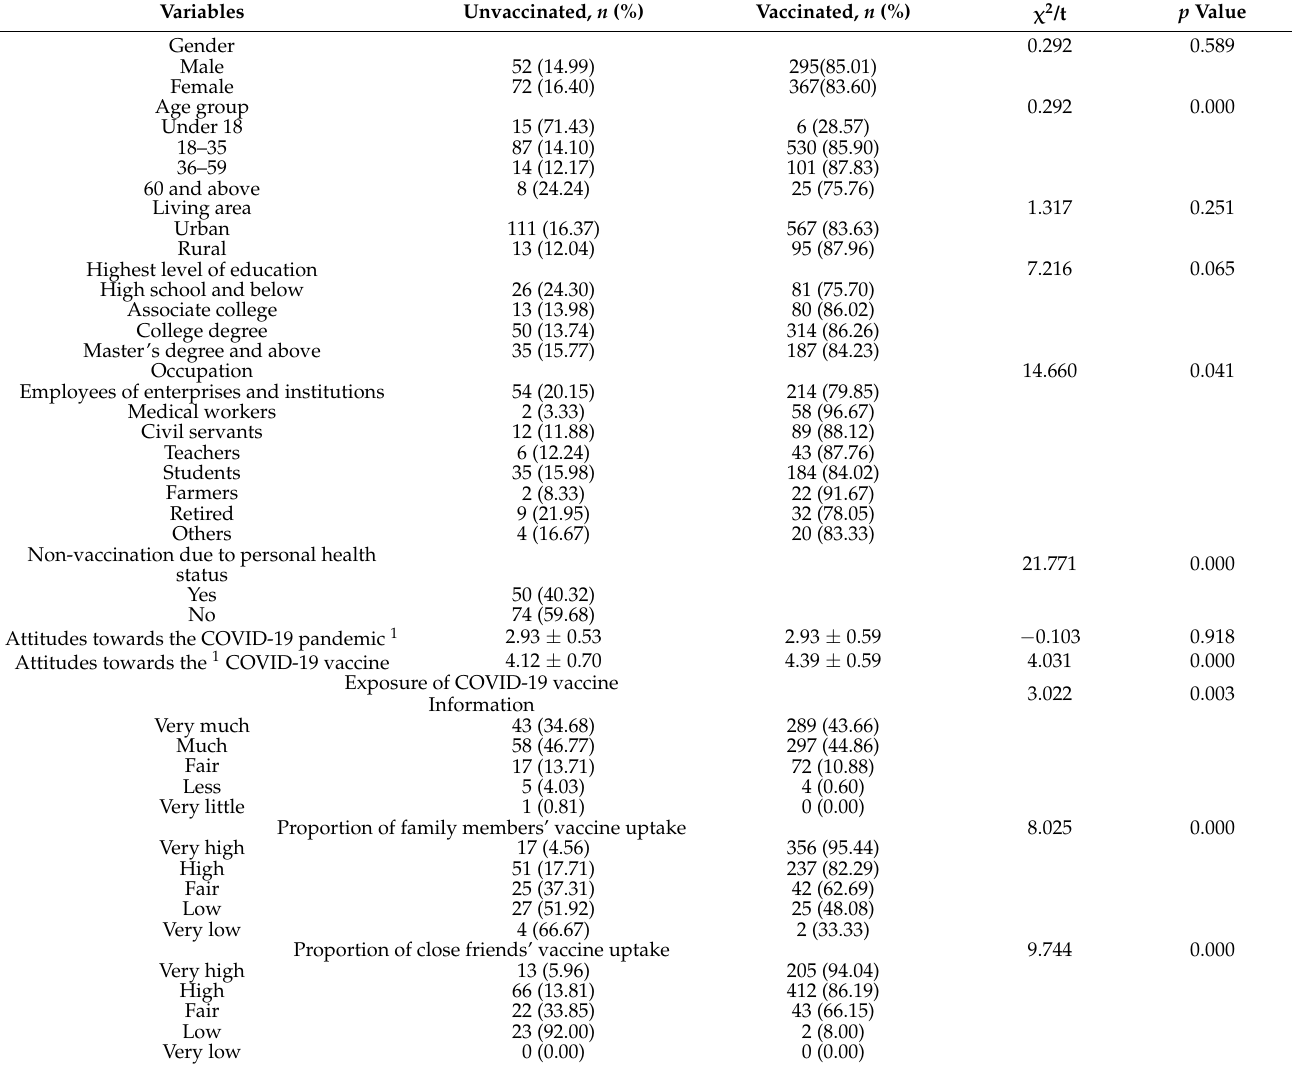
Table 4. Influencing factors of vaccine uptake between the vaccinated group and unvaccinated group.